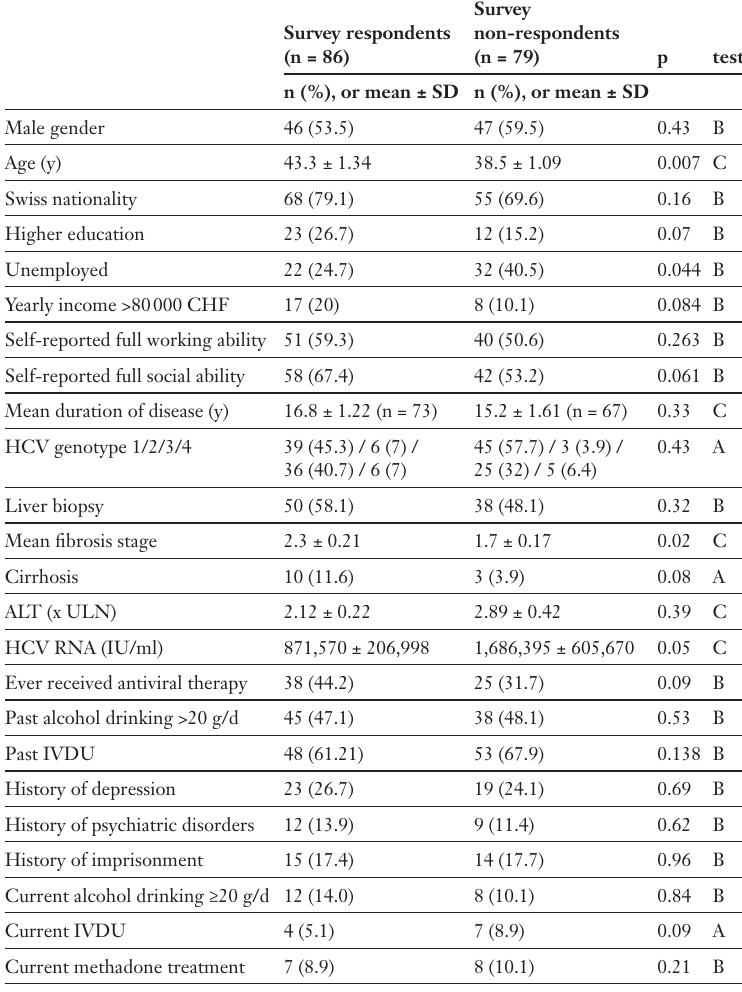
Comparison between survey respondents vs